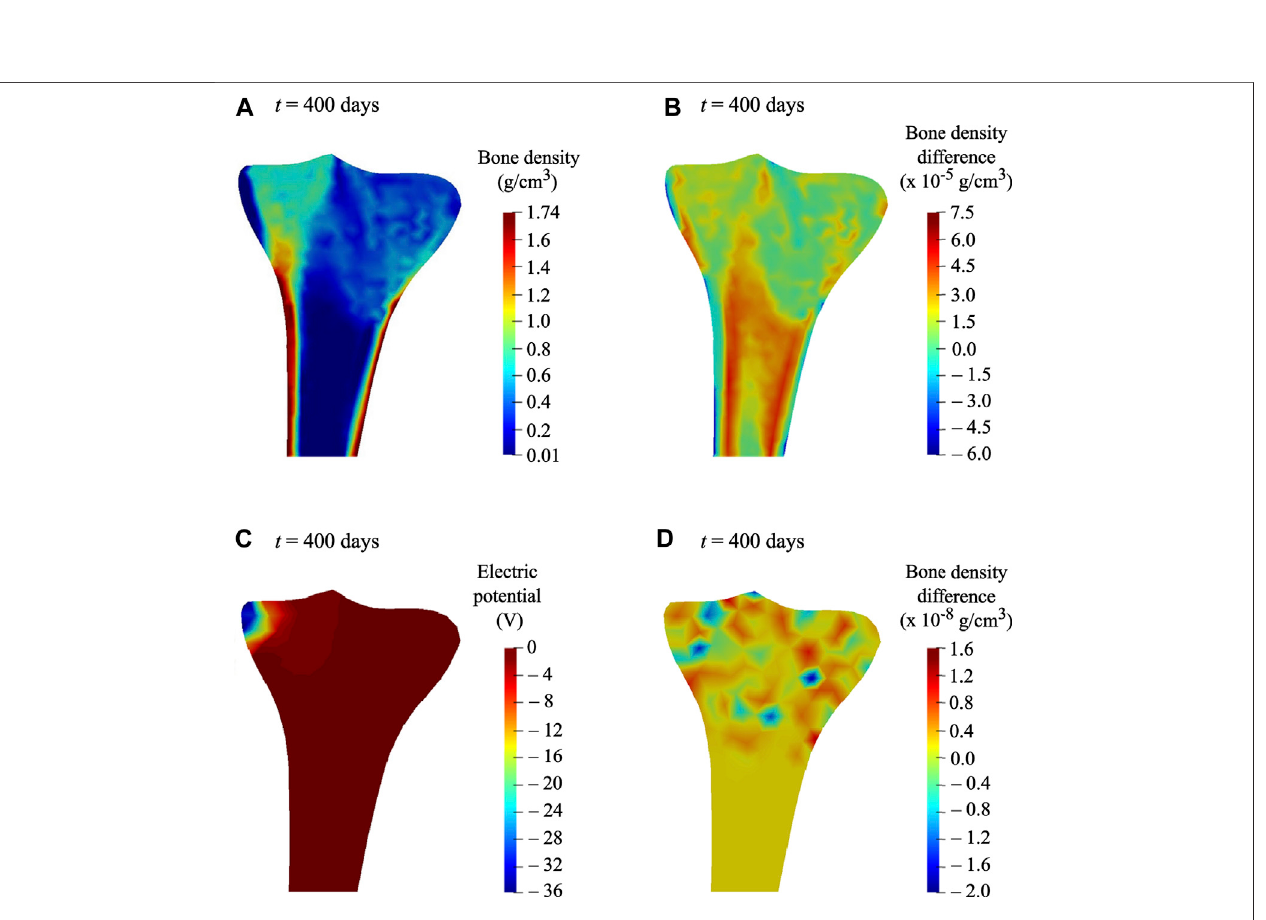
Frontiers in Bioengineering and Biotechnology |